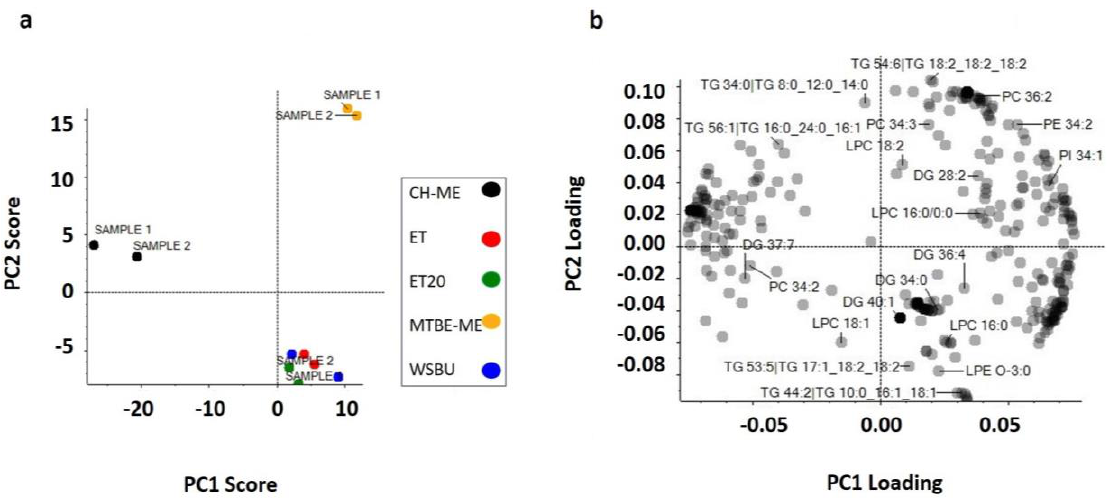
Figure 10. Principal component analysis (PC1 and PC2), with two duplicate scores for PC1 (47.5%) versus PC2 (23.8%) ( a ) and loading plot ( b